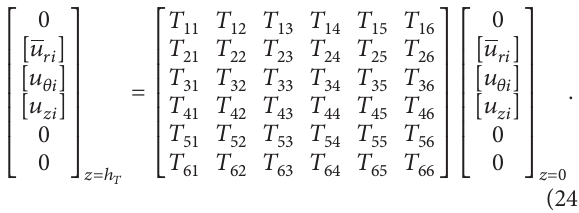
in which 𝛿(𝑧 = 0) is the state-space vector at the bottom of the plate [5]. Using this equation, the stress and displacement components in the state-space vectors are extracted in each point in the thickness direction and the other components of stress can also be calculated. Matrix 𝑀 is different for each boundary condition and it is given in Appendix